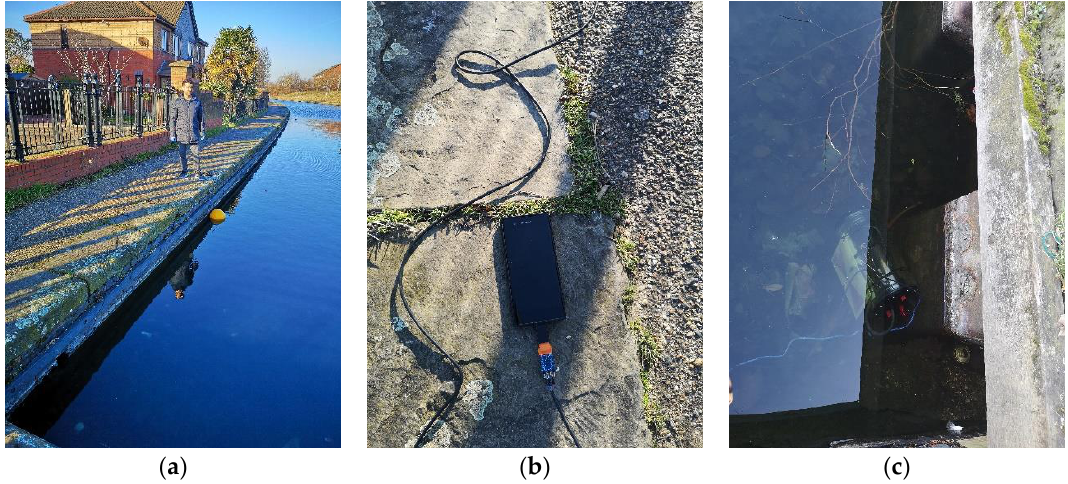
Figure 2. ( a ) experimental setup; ( b ) Data capture device; ( c ) Submerged sensor node.